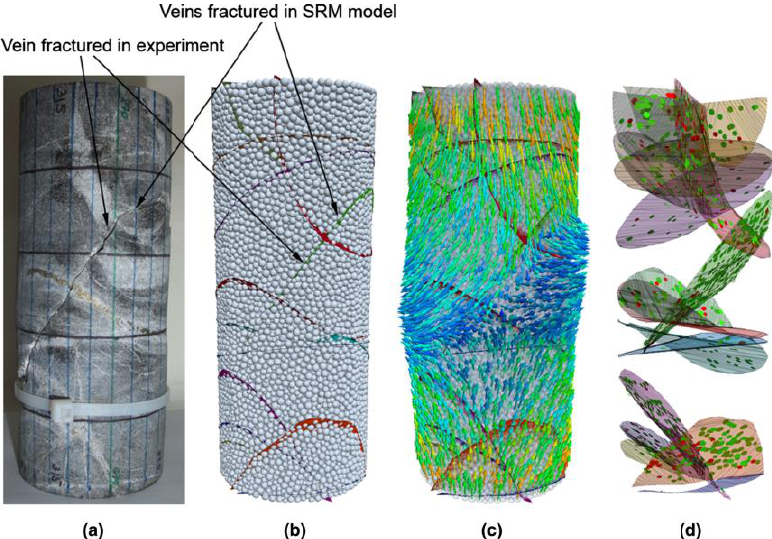
Figure 11. Illustration of a fracture developed in Specimen 1 ( a ) and in the corresponding synthetic rock mass (SRM) specimen ( b ), with displacement vectors shown in ( c ). Smooth joint contacts broken in tension (red disks) and in shear (green disks) are shown in ( d ) (reprinted with permission from Reference [27]).